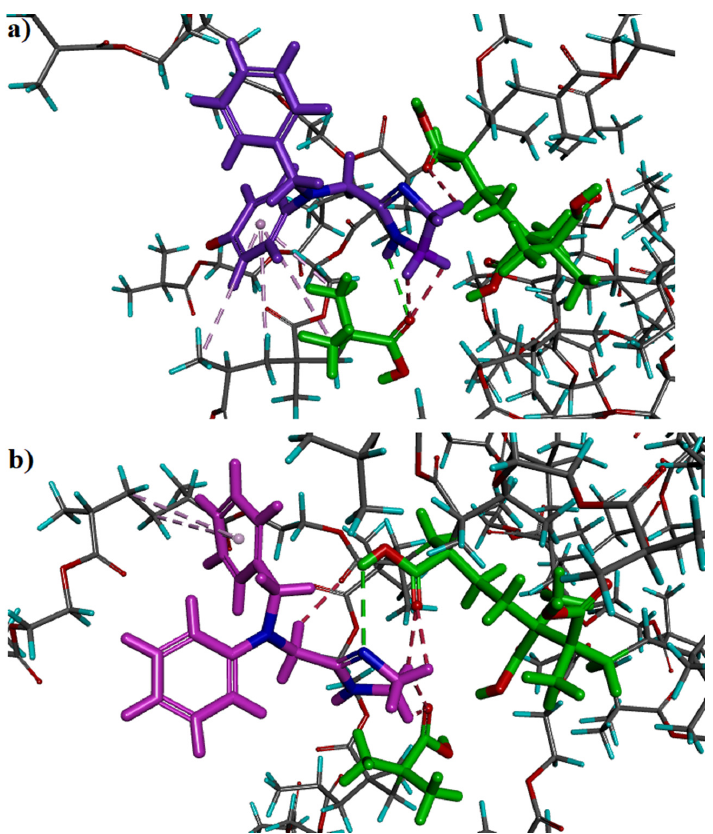
Figure 4. Views of ANT-O – ( a ) and ANT ( b ) at the end of the adsorption process in the MIP model cavity (monomers—green color); classical hydrogen bonds—green dashed lines; non-classical hydrogen bonds—red dashed lines; hydrophobic interactions—light violet dashed lines. In the adsorption process of ANT and ANT-O – , the electrostatic interactions should be also taken into account. According to analysis of charge distribution in all studied struc- tures, it was observed that both ANT and ANT-O – had very similar values of charge on the N atom located in the alkyl chain: − 0.2292 and − 0.2254, respectively (Figure A1 in Ap- pendix A). The charge values of the N atoms in alkyl chains in the ANT + , ANT-OH, or ANT + -O – differed significantly from those observed for the ANT and ANT-O – molecules.